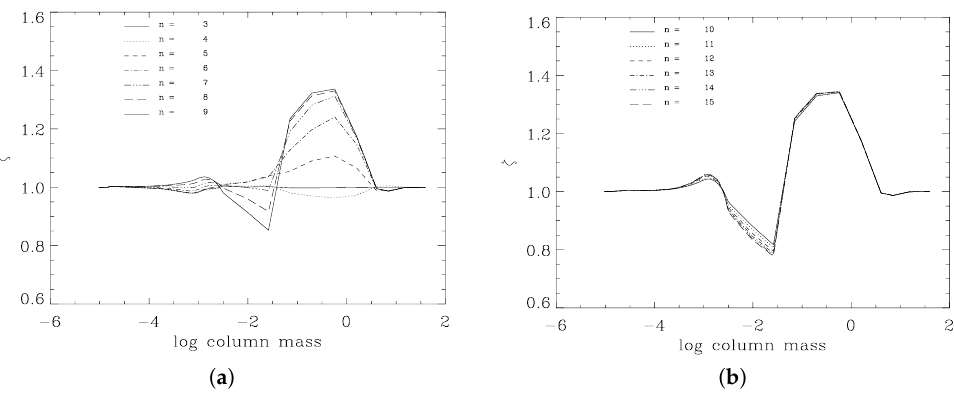
Figure 11. ( a ) the behavior of the population ratio ζ for 3 ≤ n ≤ 9 as a function of the column mass; ( b ) same as in ( a ) but for 10 ≤ n ≤ 15 (from [25]).